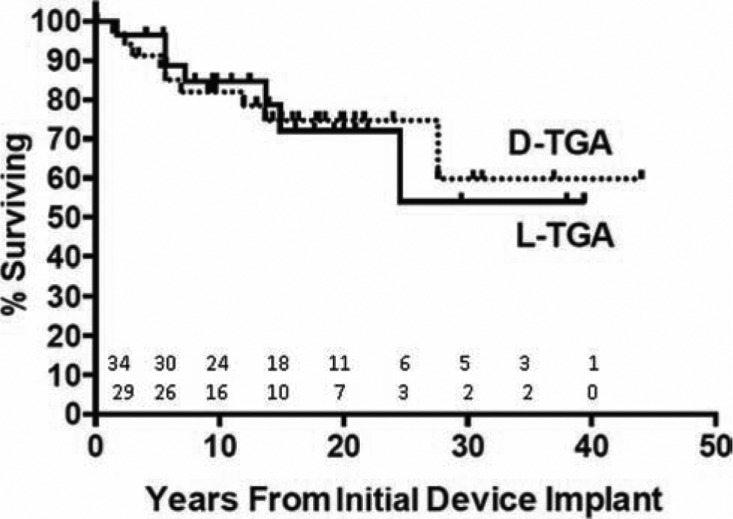
Kaplan-Meier curves comparing survival following implantation of initial cardiac device. No difference was seen between the dextro-transposition of the great arteries (d-TGA) and l-TGA (levo-transposition of the great arteries) groups (p = 0.998). l-TGA patients were, however, significantly older at the time of implant than their d-TGA counterparts (35.6 ± 18.2 versus 17.3 ± 10.6 years, p<0.001).